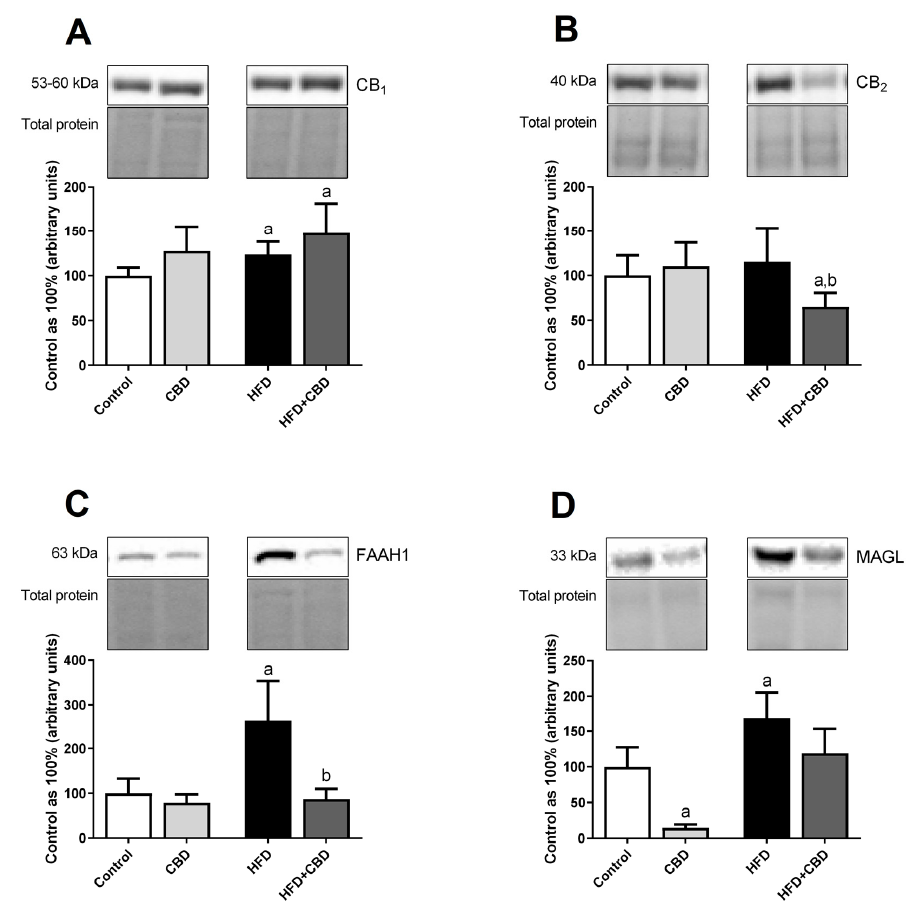
Figure 6. The total myocardial expression of cannabinoid receptor 1 (CB 1 ) ( A ), cannabinoid receptor 2 (CB 2 ) ( B ), fatty acid amide hydrolase 1 (FAAH1) ( C ), and monoacylglycerol lipase (MAGL) ( D ) in the left ventricle homogenates after 2-week cannabidiol (CBD) administration in rats fed a standard diet (Control) or a high-fat diet (HFD). The protein expression was determined by Western blotting method, normalized to the total protein loading in each lane, and presented as a percentage difference in comparison to the control group, which was set at 100%. The results are expressed as mean values ± SD and are based on six independent determinations in each group. a p < 0.05 significant difference vs. control group; b p < 0.05 significant difference vs. high-fat feeding